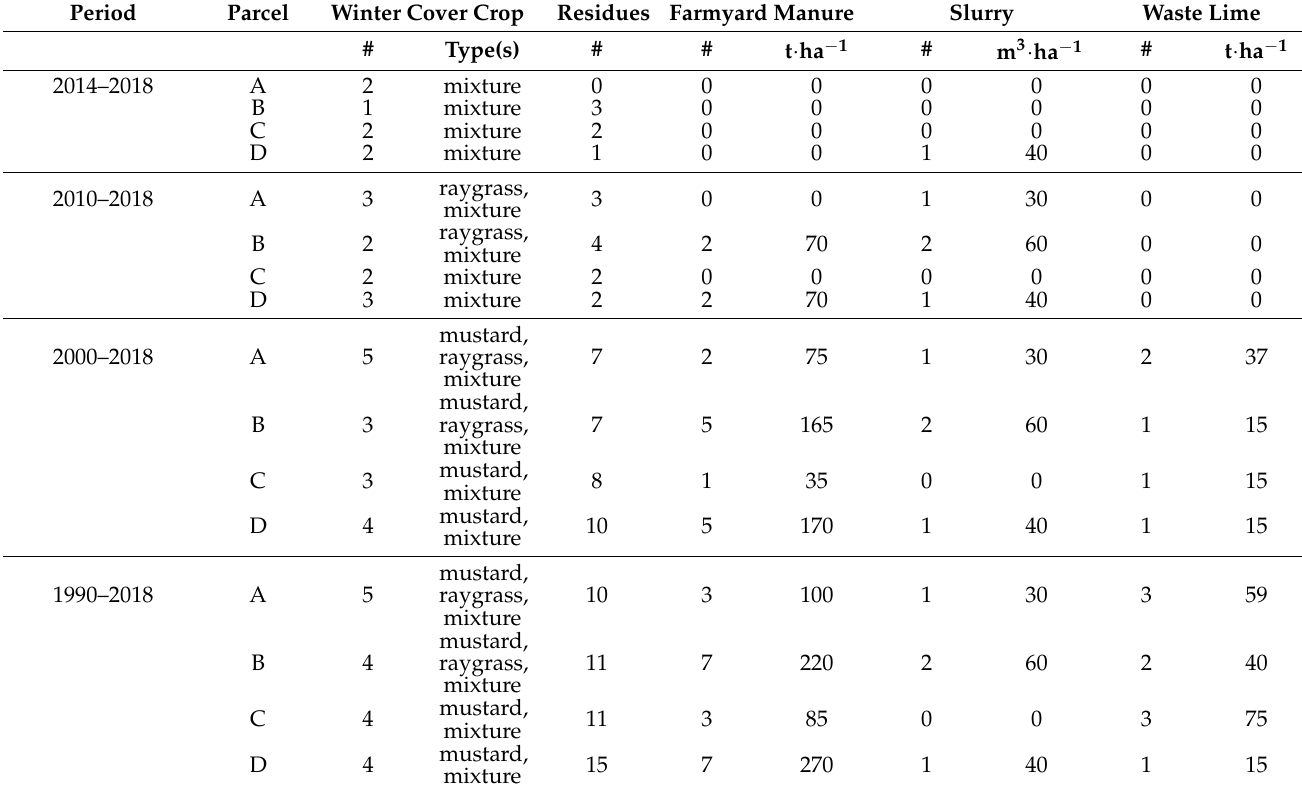
Table 4. Summary of historical soil and crop management practices data related to organic matter resti- tution or application in each of the four parcels (A, B, C, and D) of the former field layout (see Figure 1). of occurrences. Residues = crop residues restitution.